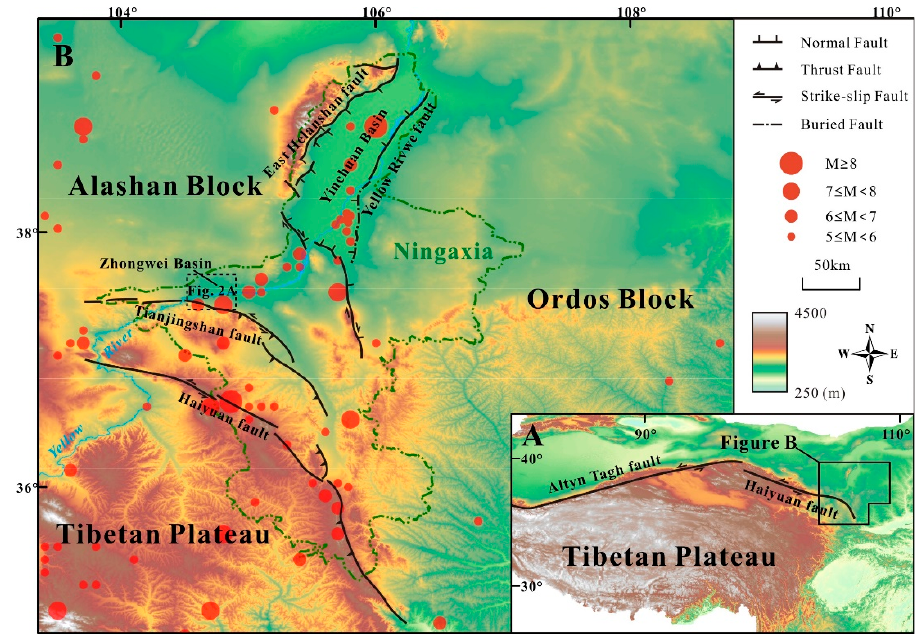
Figure 1. The tectonic setting of Ningxia. ( A ) Regional tectonic map on the Tibetan Plateau. The black box shows the location of ( B ). ( B ) Topographic and Seismotectonic map of the Ningxia and the surrounding area. Black bold lines in the map represent major active faults. Red solid circles represent the destructive earthquake epicenters ( M ≥ 5). Dashed black box shows the location of Figure 2A.